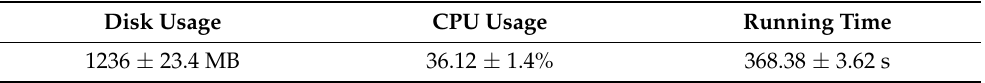
Table 11. Computational cost of DANCE on the Indian Pines